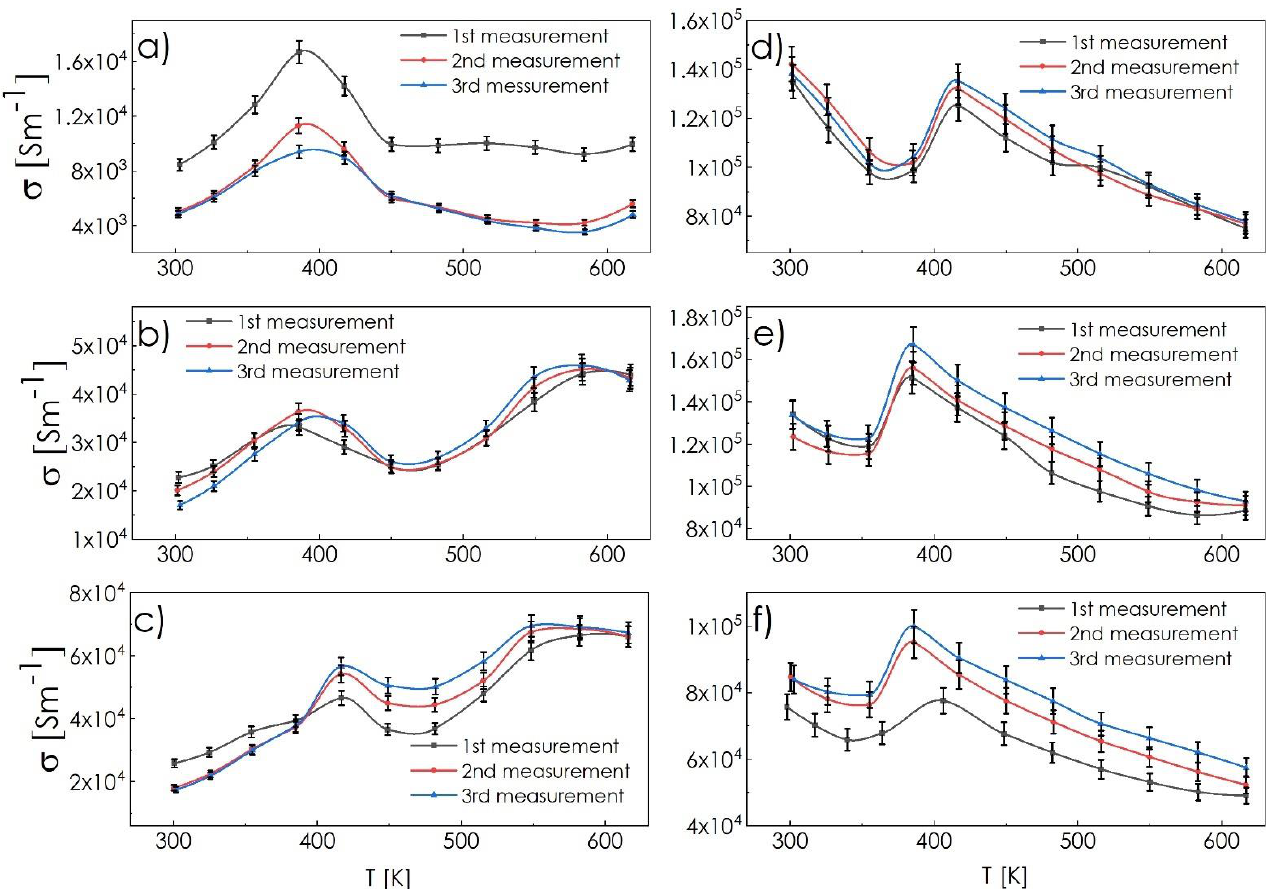
Figure 5. Cyclic measurements of electrical conductivity as a function of temperature recorded for the composite ingots: ( a ) CSS1, ( b ) CSS5, ( c ) CSS10, ( d ) CSE1, ( e ) CSE5, ( f ) CSE10.